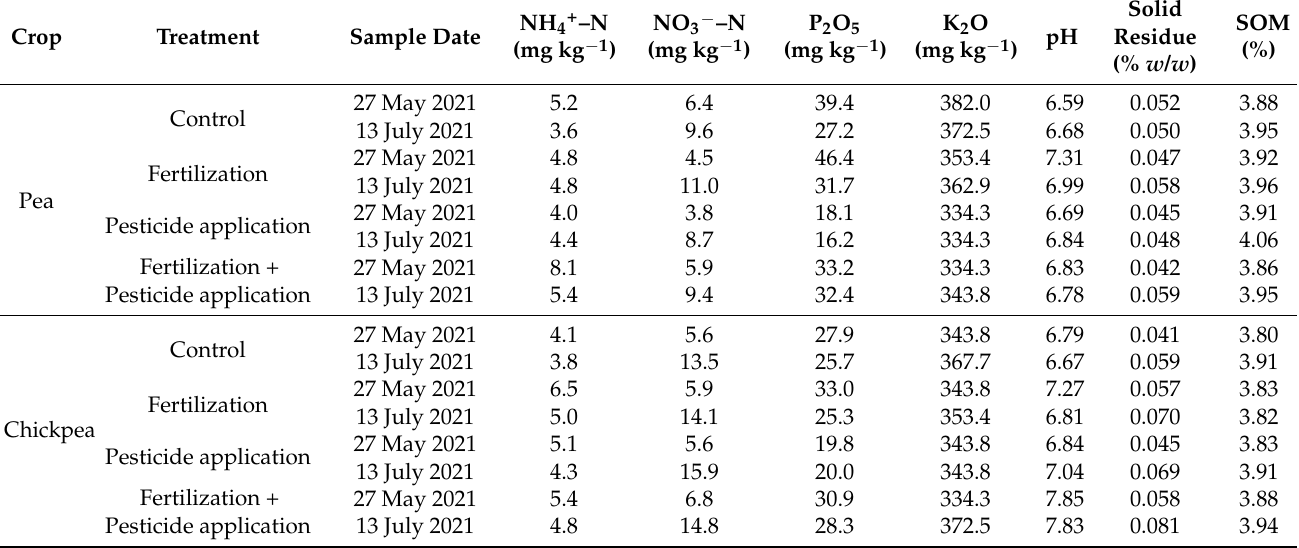
Table 2. The physicochemical characteristics of